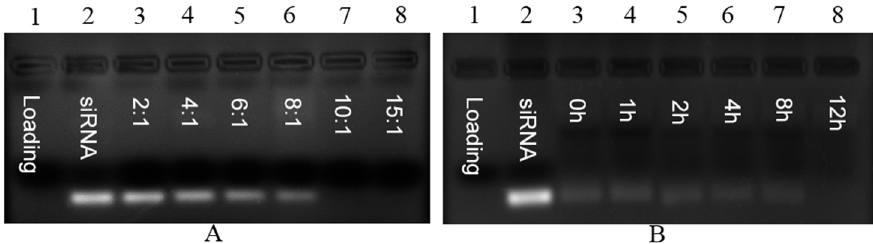
Figure 2. Gel retardation assay. ( A ) Electrophoretic analysis of P/LNPs-small interfering RNA (siRNA) at various mass ratios; ( B ) Stability study of P/LNPs-siRNA in 50% serum.